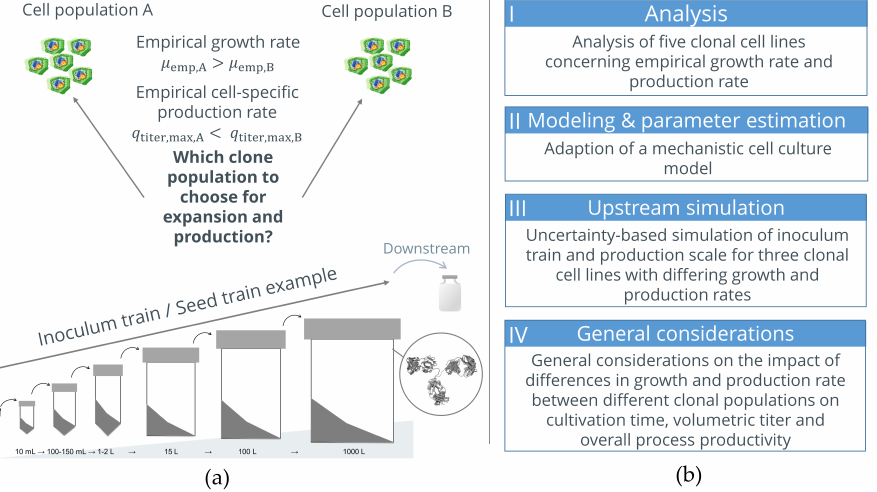
Figure 1. ( a ) Problem definition: Find the clone with a higher potential regarding inoculum train creation and final quantities of interest (volumetric titer in production and overall process productivity (=Space-Time-Yield; volumetric titer in production/overall cultivation time including inoculum train)). ( b ) Structure of the presented